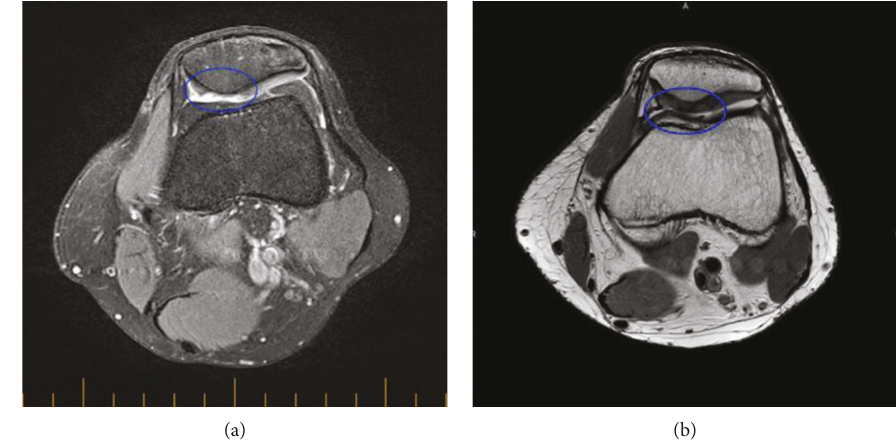
Figure 5: (a) Pretreatment proton density fat-suppressed axial MRI of the knee showing the isolated chondral defect involving the medial facet of the patella. (b) Posttreatment proton density axial MRI indicating articular cartilage regeneration at the site of the chondral defect with smooth integration with the surrounding joint surface